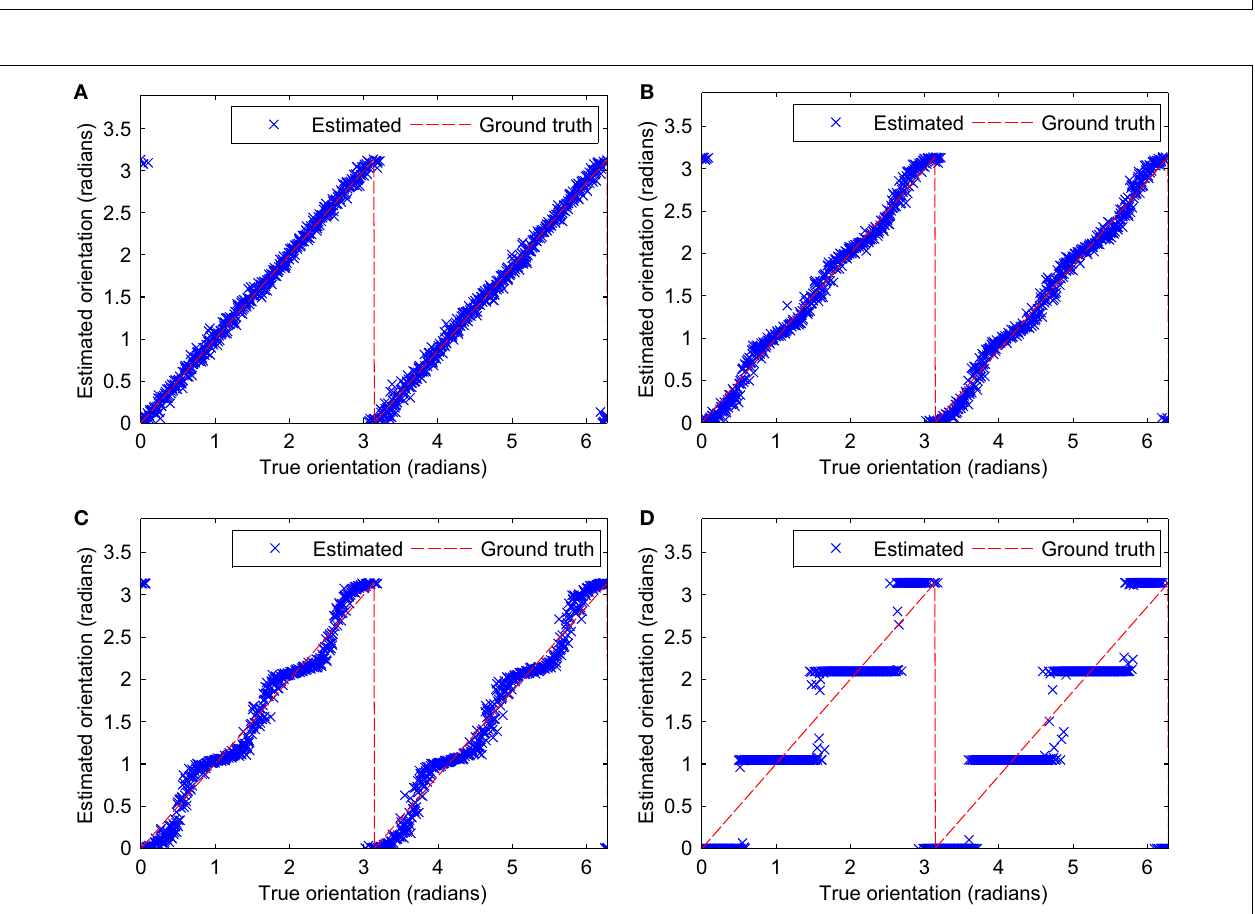
FIGURE 11 | Evaluation results using stimuli from Figure 9 for three channels . (A–D) decoding with respectively 0, 5, 10, and 100 iterations according to (9).